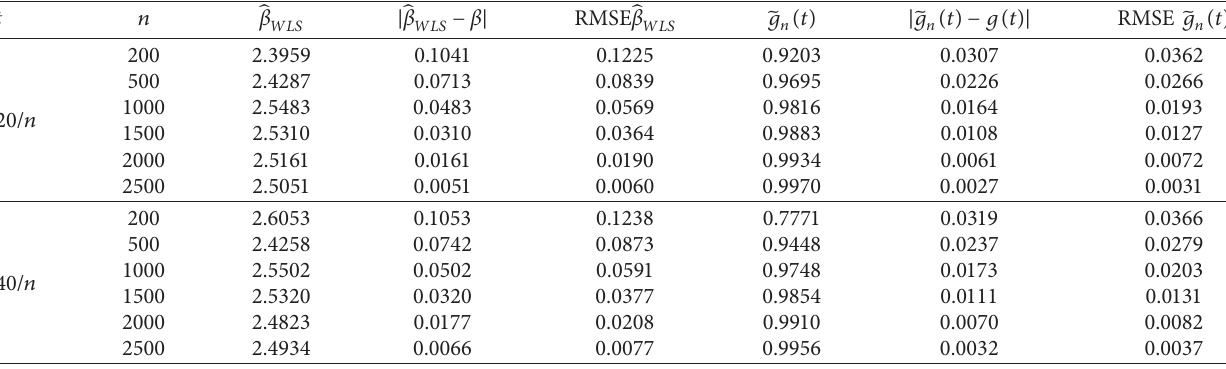
􏽥 g ( t ) with β � 2 . 5 and g ( t ) � cos ( π t ) . n WLS and